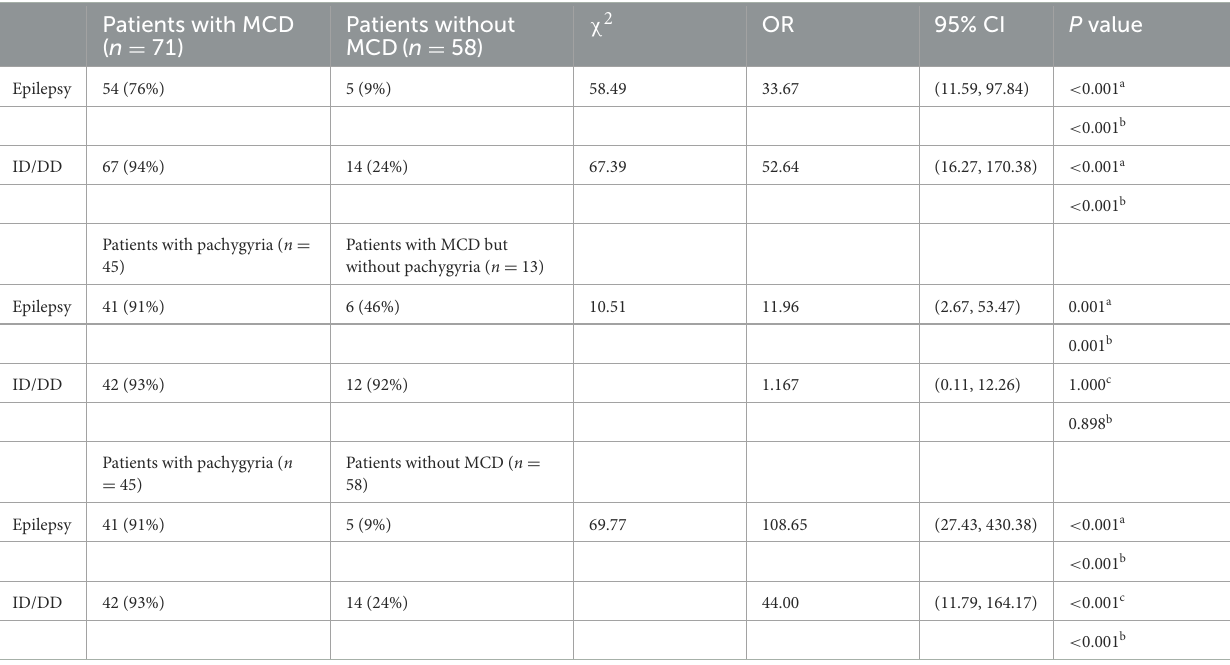
TABLE 1 Comparison of central nervous system disorders in patients with DYNC1H1 variants with or without malformations of cortical development and with or without pachygyria. Patients with MCD Patients without ( n = 71) MCD ( n =